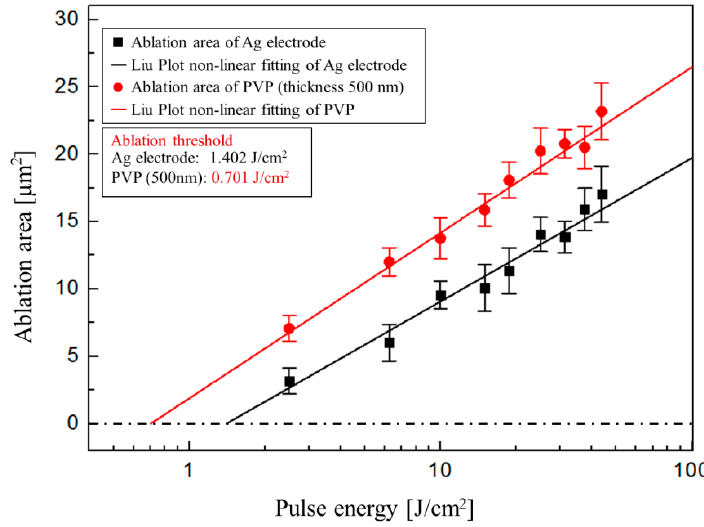
Figure 3. Liu-plot of ablation areas for laser irradiation on sintered Ag electrode and PVP insulating layer. The value of the ablation threshold has been extracted from experimental results. (Liu-plot non-linear